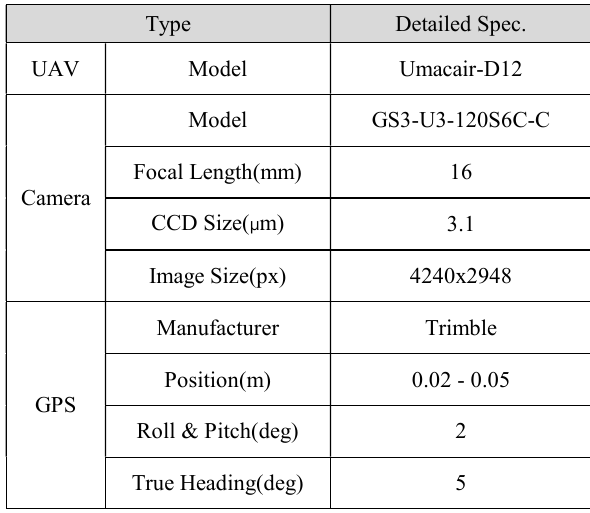
Table 1. Specification of UAV system